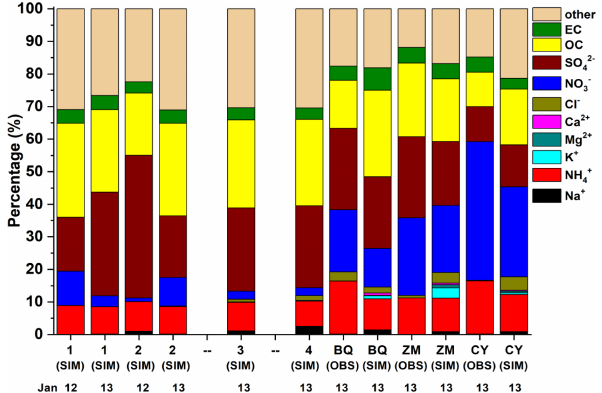
Figure 11. The comparison of the simulation (SIM) and observation (OBS) of PM 2 . 5 compositions at position 1–4 and BQ, ZM, and CY in Fig. 1 on 12 and 13 January